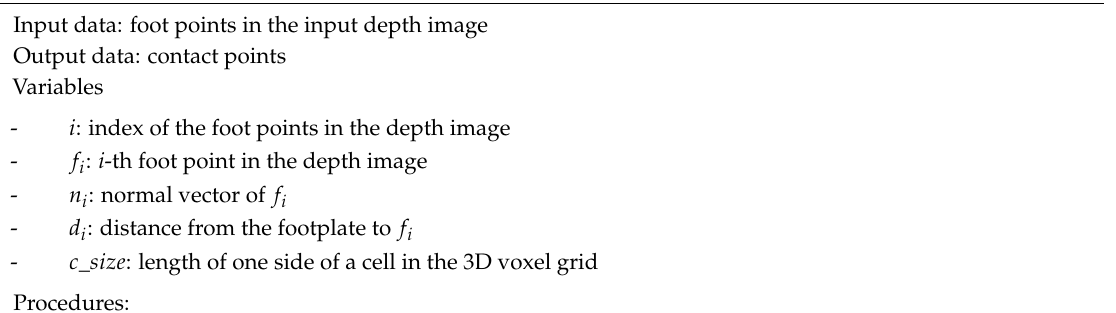
Algorithm 1 Procedures of Contact Point